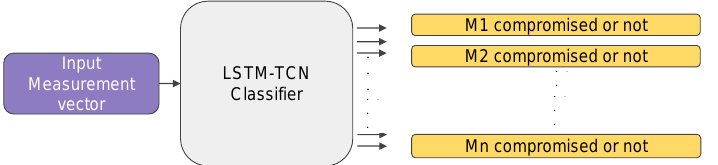
Figure 1. FDIA’s proposed location-based detection